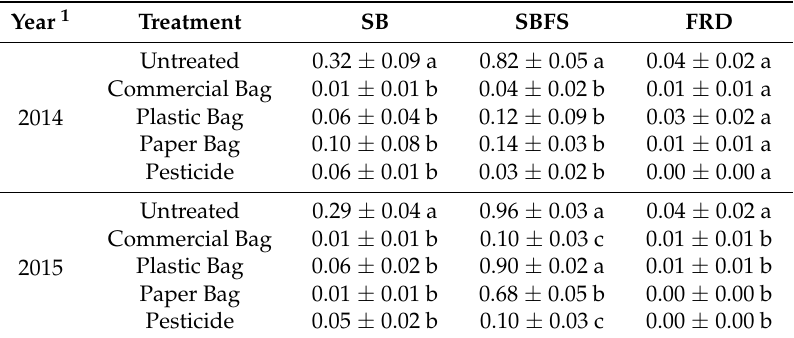
Table 5. Mean (±SE) proportion of fruit damaged by disease. Table 5. Mean ( ± SE) proportion of fruit damaged by disease.